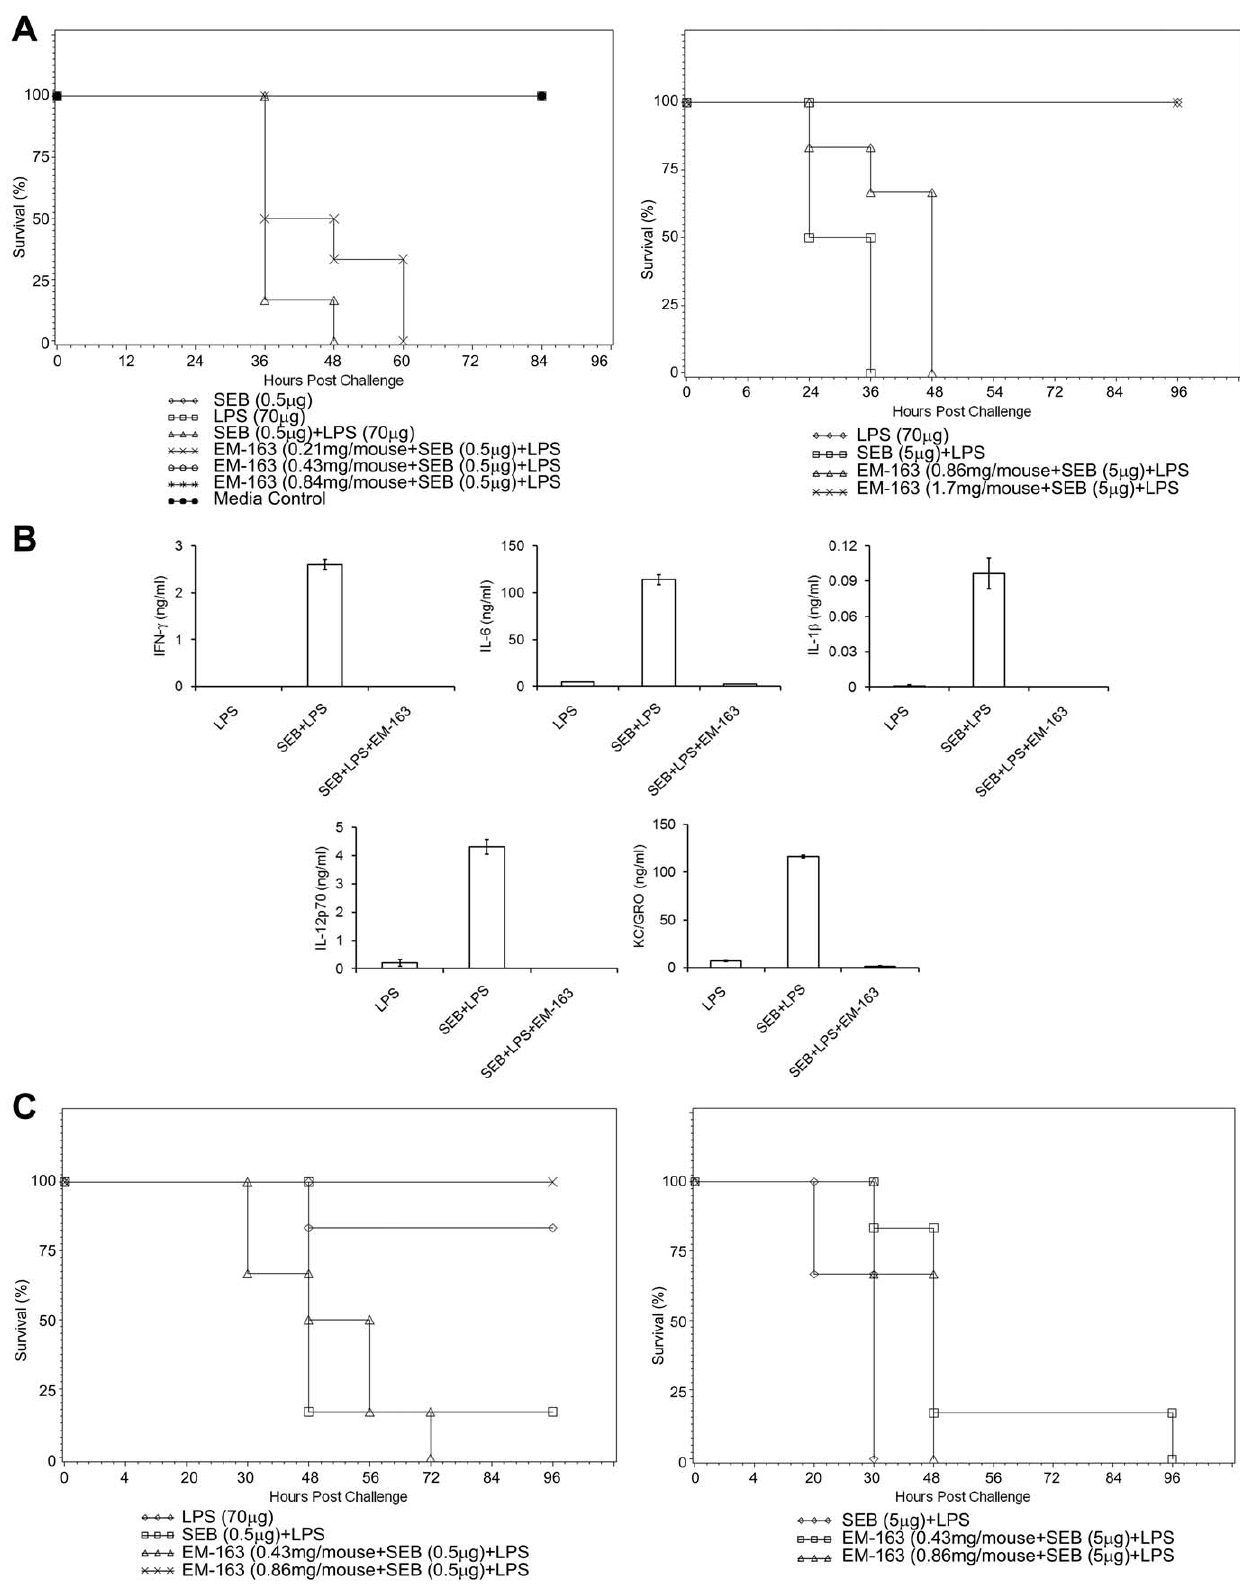
Figure 8. EM-163 attenuates SEB -induced pro-inflammatory serum cytokines and lethality in mice. BALB/c mice (n=6) were injected (i.p.) with different amounts of EM-163, 30 min later injected with SEB followed by LPS 2 h later. Mice were observed to determine if mice survived, or time to death if they did not. Control mice injected only with 60 m g of LPS or 1 m g of SEB survived. Data represent three separate experiments. Kaplan